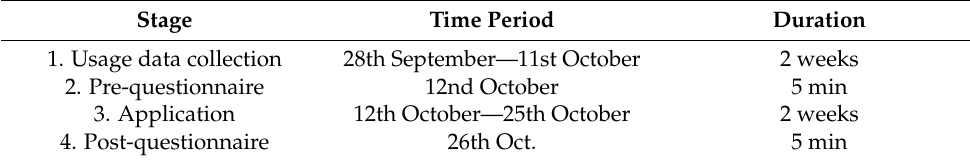
Table 1. Evaluation stages for the digital wellbeing conversational